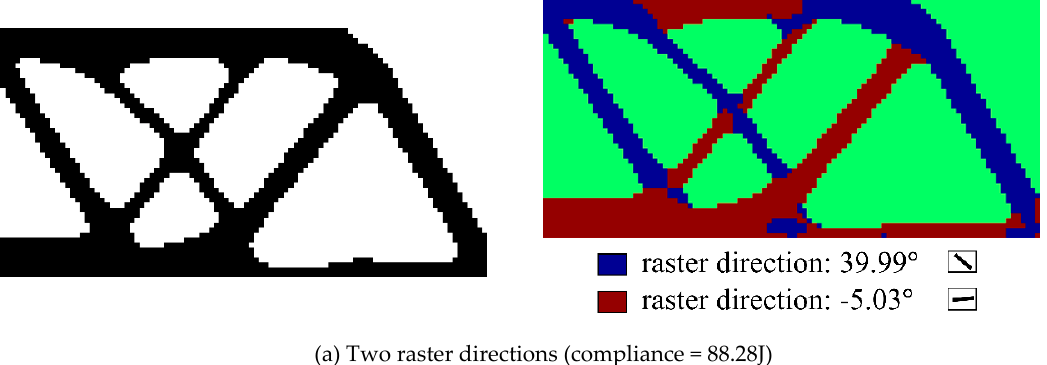
Figure 11. Schematic of the MBB structure problem definition.